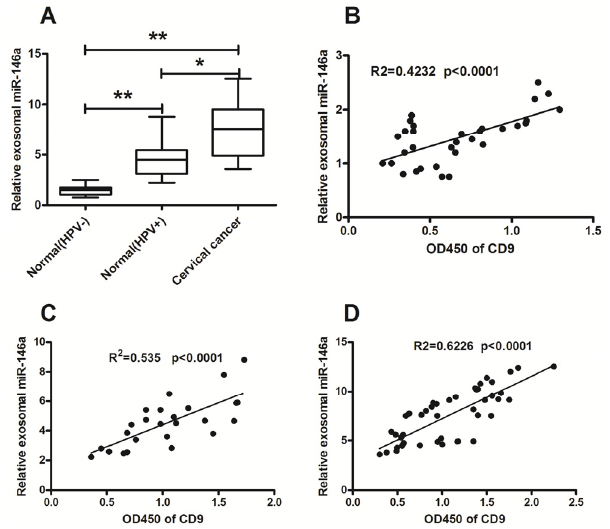
Figure 3. Enriched exosomal microRNA-146a in cervicovaginal lavage specimens of cervical cancer patients. ( A ) The relative amounts of miR-146a were examined by RT-qPCR in cervicovaginal lavage specimens of the HPV-negative normal subjects ( n = 32), the HPV-positive subjects ( n = 25), or the cervical cancer patients ( n = 45). The lowest expression in the normal (HPV-) group was designated as “1”. All other samples were expressed as a relative value according to the ratio of their Cp value to the Cp value of the designated sample; ( B – D ) The correlation between the miR-146a expression and the level of exosomes was evaluated by RT-qPCR and ELISA; ( B ) HPV–negative normal group; ( C ) HPV-positive group; ( D ) Cervical cancer patient group. All experiments were performed in triplicate. Statistical significance was considered with a p < 0.05 ( * ) and a p < 0.01 ( ** ).